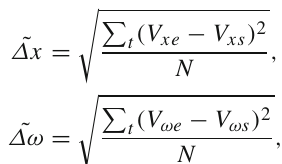
sion speed of the biomimetic robotic fish are shown versus the time. Figure12b compares the simulation and actual test results of the head swing angle of the biomimetic robotic